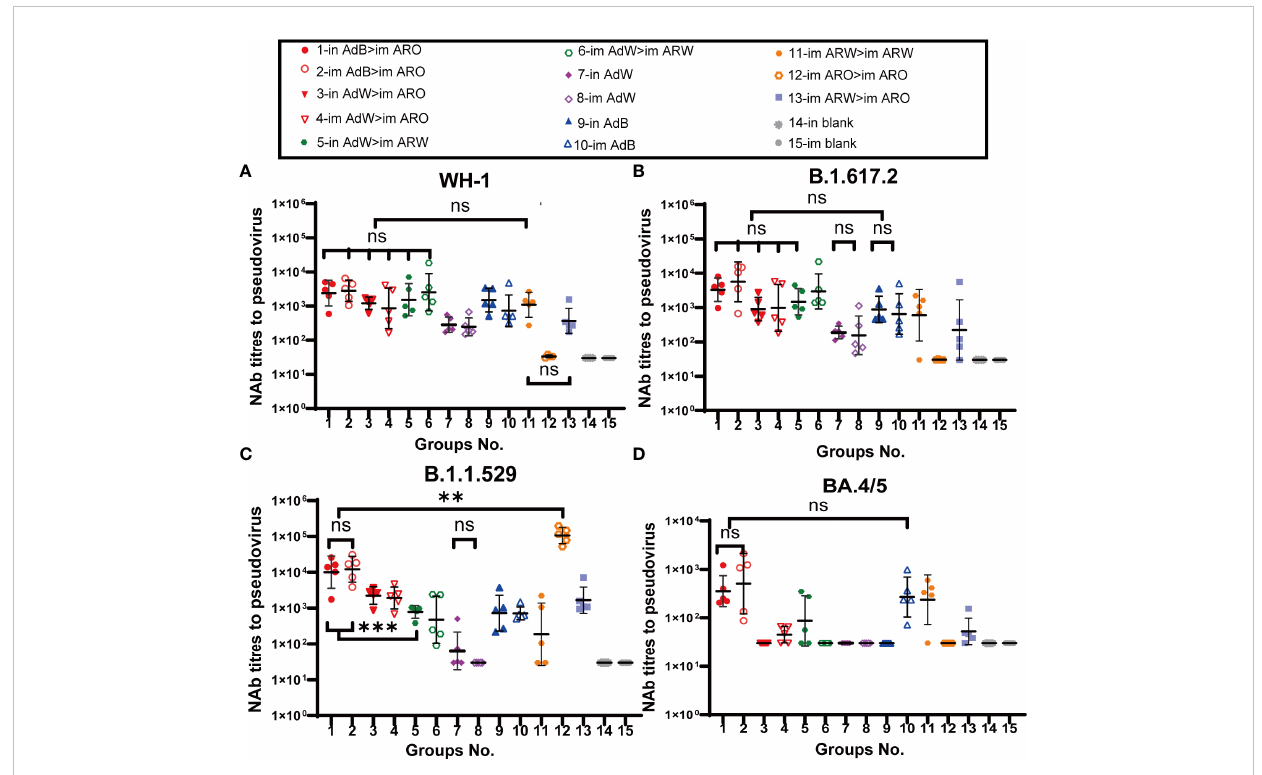
FIGURE 3 Pseudovirus-neutralising antibody (PNAb) titres were measured 35 days after primary immunisation. Serum NAb titres against (A) WH-1, (B) B.1.617.2, (C) B.1.1.529, and (D) BA.4/5 are expressed as 50% inhibitory dilutions (n = 4 − 5 per group; one spot represents one sample). Bars represent the geometric mean ± geometric SD; **P < 0.01; ***P < 0.001; ns, P >